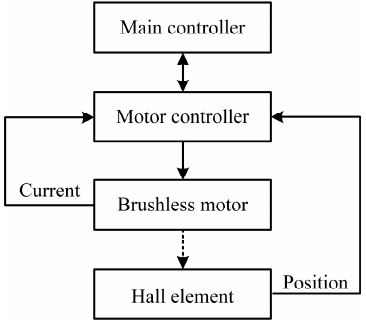
Figure 13. The cuttage depth sensing system of the arch shed pillar with “current–force–depth” real- time feedback.